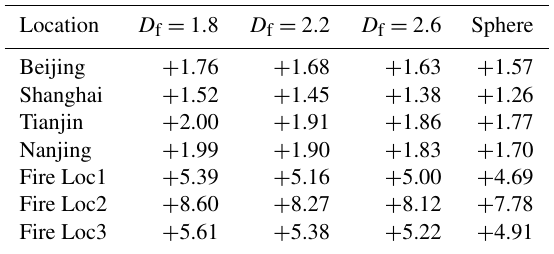
Table 1. Time-averaged BC clear-sky ARI at different sites (Wm − 2 ).